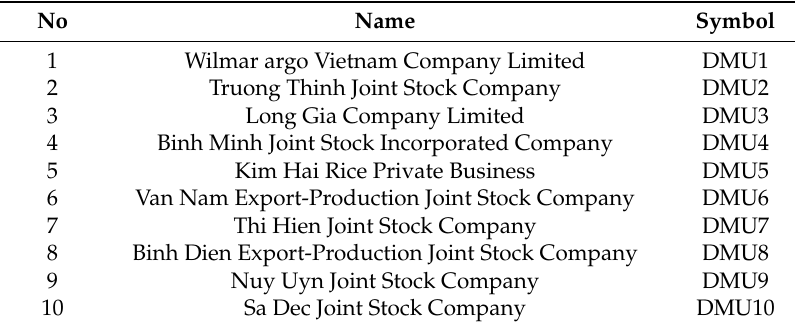
Table 2. The symbol of ten edible Oil suppliers.